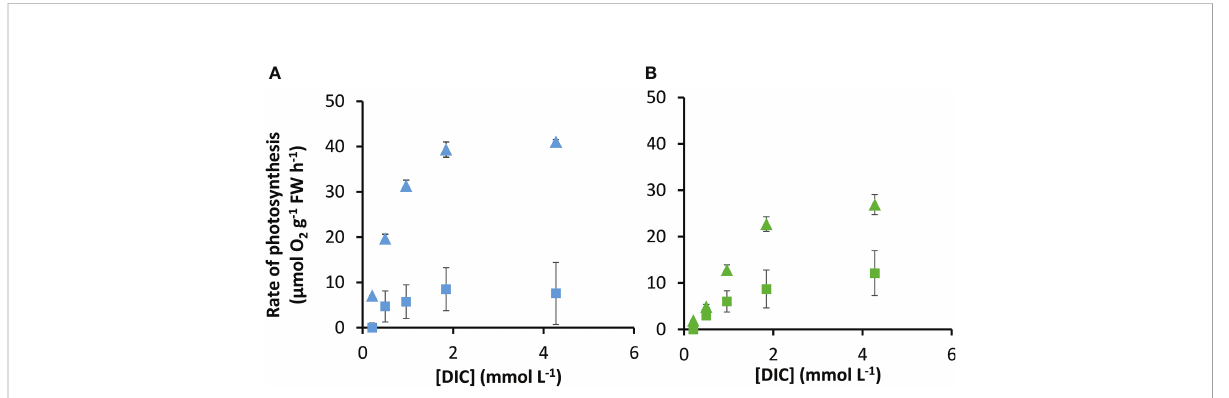
FIGURE 1 Measured response of photosynthesis by P. oceanica and Z. marina to concentrations of DIC. Measurements were made at air-equilibrium CO 2 (squares) and after reducing the pH to 7 (triangles) for P. oceanica (A) and Z. marina (B) . Mean and standard deviation of triplicate measurements are shown.